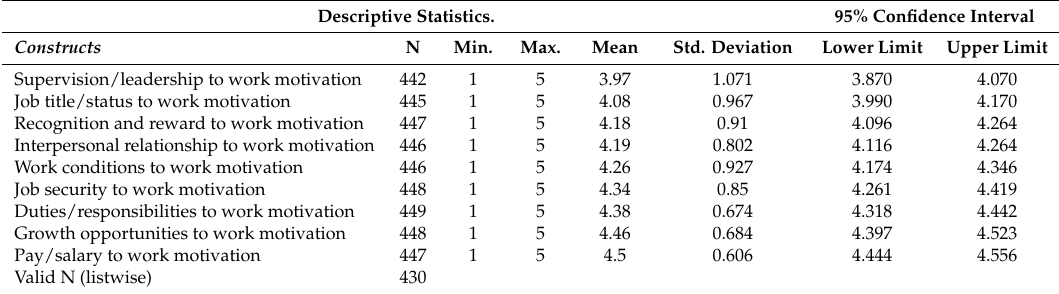
Table 1. Descriptive results—important job characteristics and job attributes that support motivation. Descriptive Statistics. 95% Confidence Interval Constructs N Min. Max. Mean Std. Deviation Lower Limit Upper